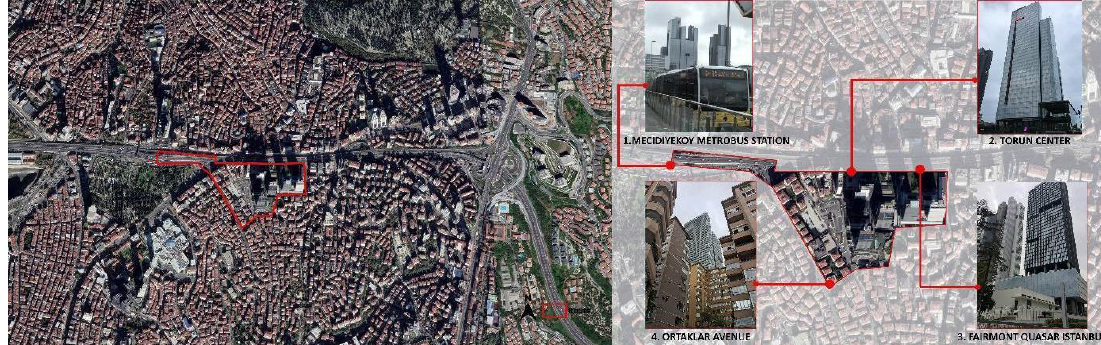
Figure 1 Aerial view of Mecidiyeköy and the route and stops of the research area (Photograph credits: personal archive of Feride Gül Keleş, 2019)